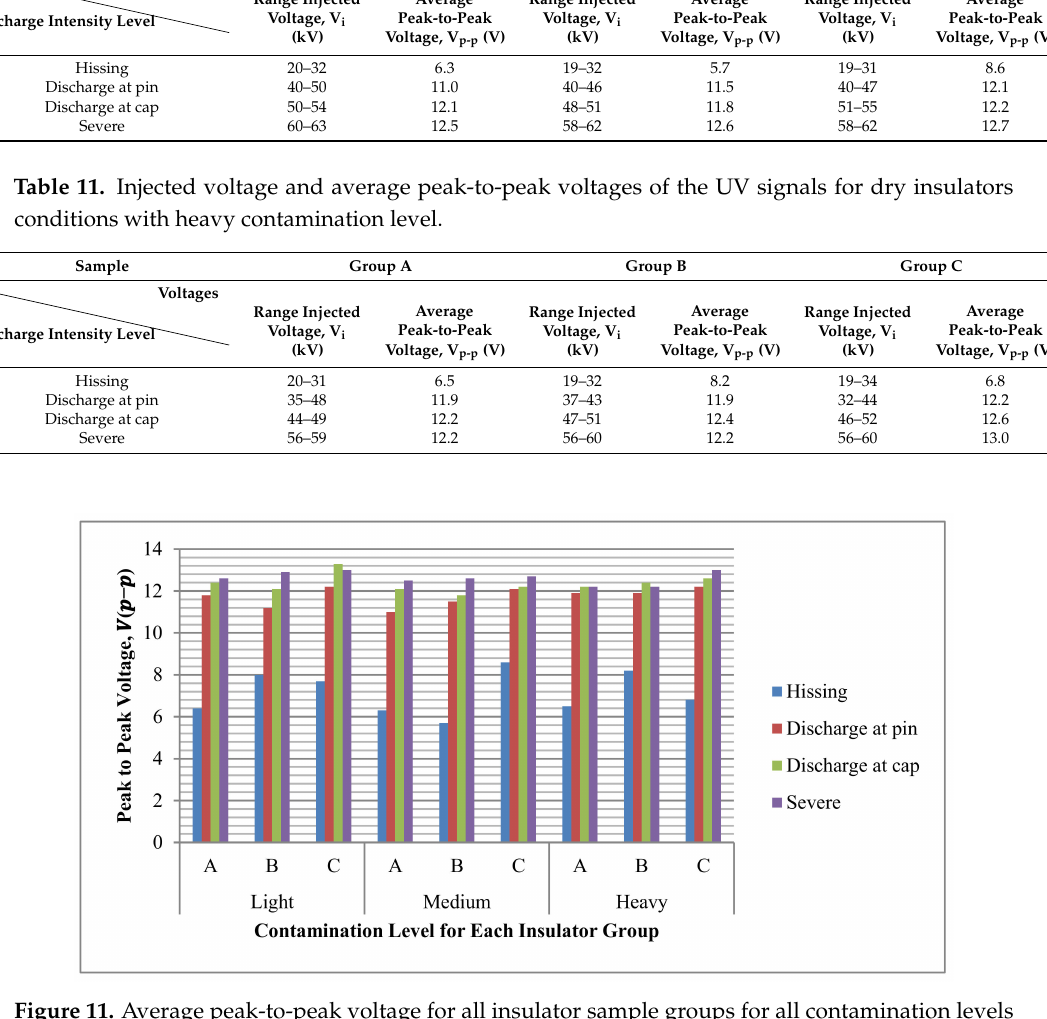
Figure 11. Average peak-to-peak voltage for all insulator sample groups for all contamination levels under dry